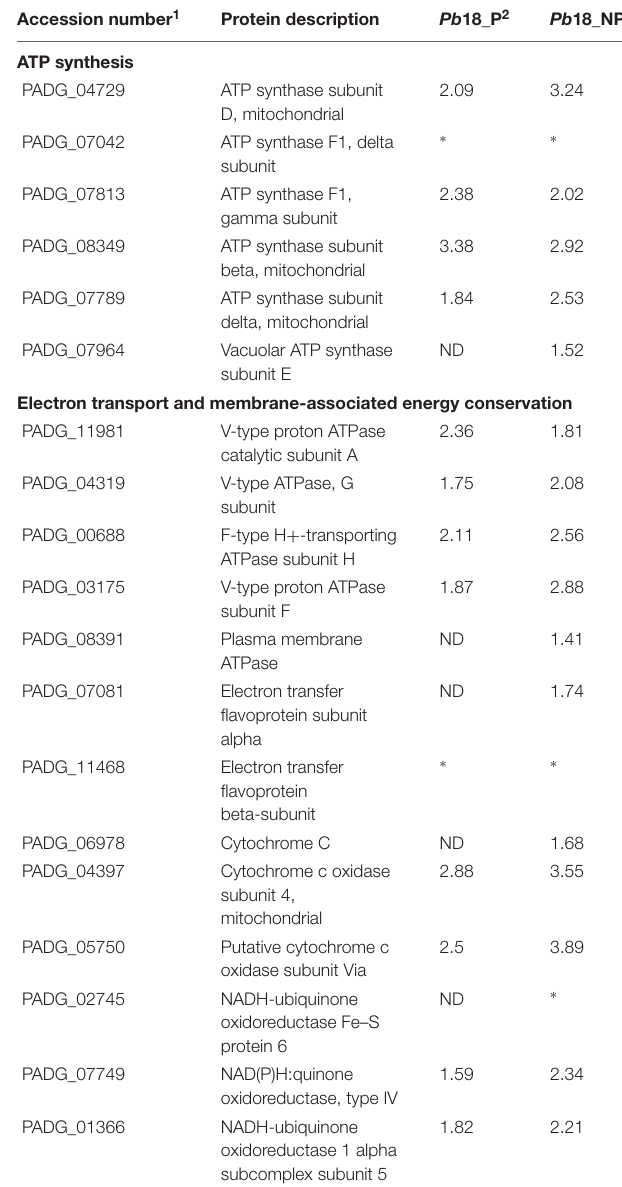
TABLE 3 | Up-regulated proteins related with mitochondrial activity in Pb 18_A and Pb